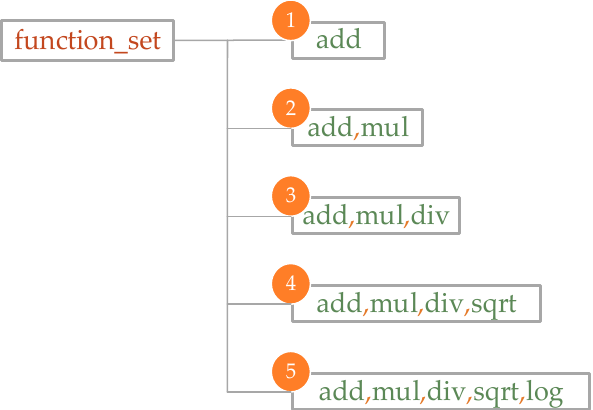
Figure 7. Regression symbol setting schemes.